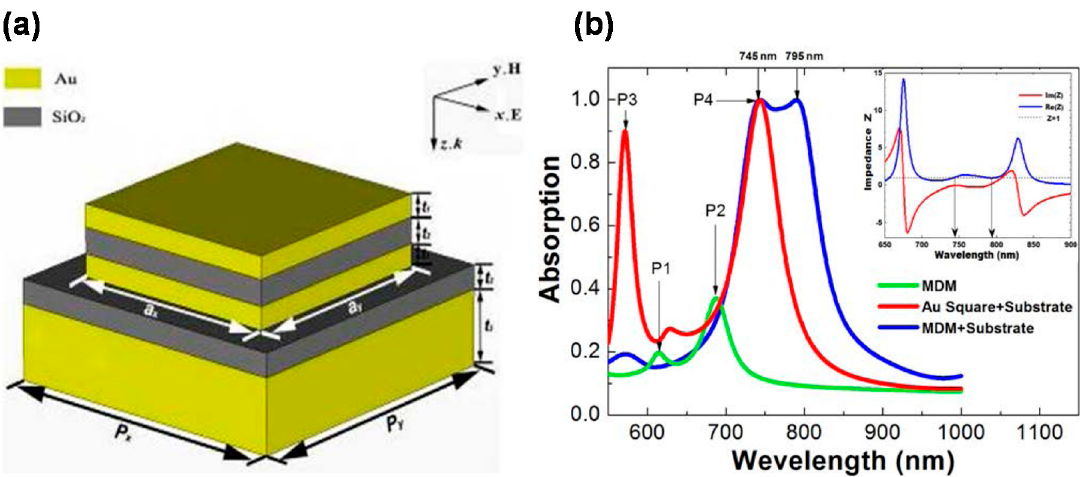
Figure 9. ( a ) Schematic illustration of a multi ‐ layer MIM ‐ PMA and ( b ) the calculated absorption spectrum. Figures are adapted with permission from Reference [95]. © 2012 Optical Society of America.